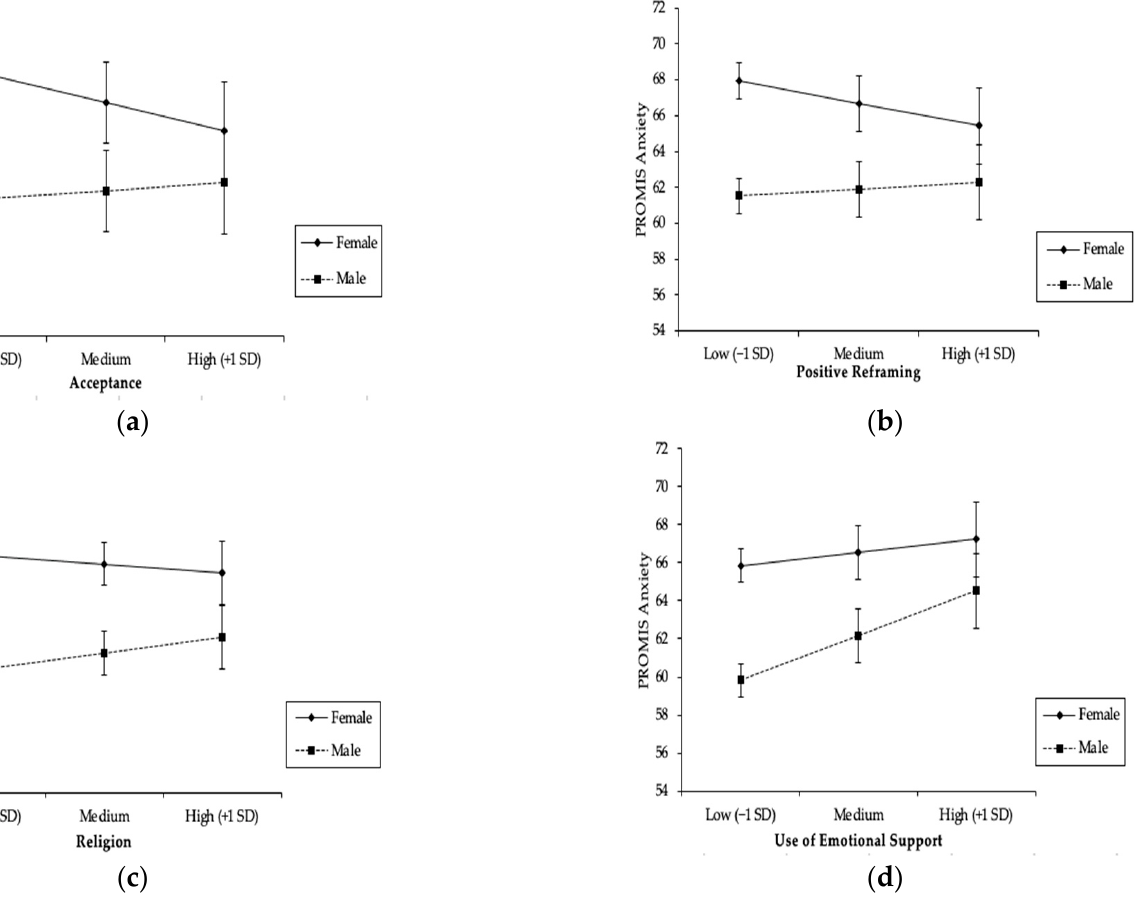
Figure 2. Results of Linear Regression Analysis Showing PROMIS Anxiety Scores as a Function of Emotion-focused Coping Strategies and Gender: ( a ) moderation by gender on the effect of acceptance on PROMIS Anxiety; ( b ) moderation by gender on the effect of positive reframing on PROMIS Anxiety; ( c ) moderation by gender on the effect of religion use on PROMIS Anxiety; ( d ) moderation by gender on the effect of emotional support use on PROMIS Anxiety.